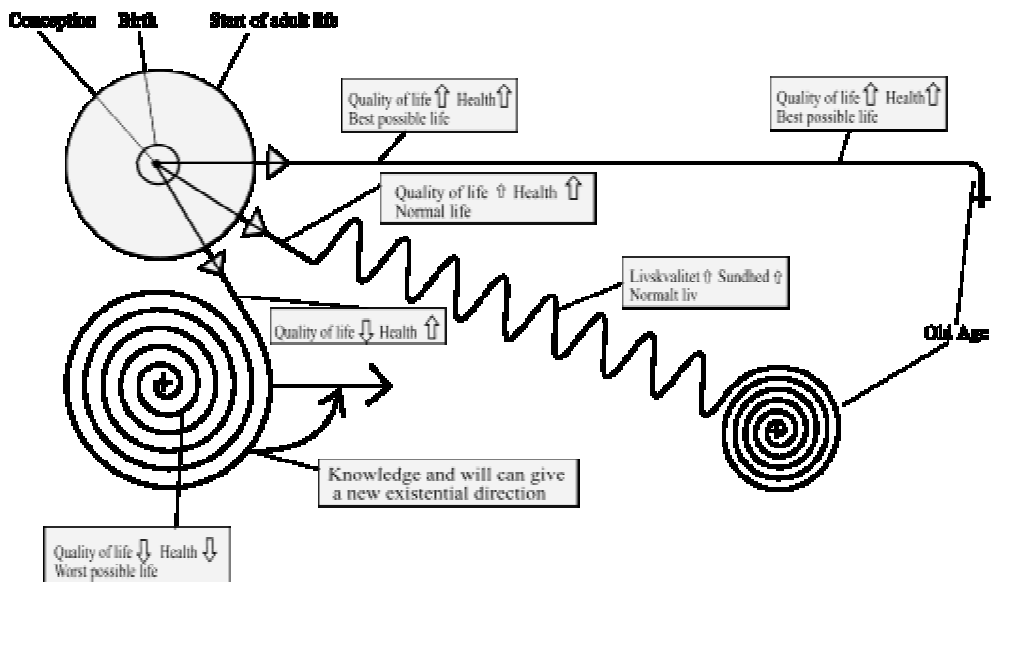
FIGURE 2 . The three paths of life[4]: the good life with optimal QOL, health and ability of functioning, the average, normal, life with sub-optimal QOL, health and ability, and the poor life with low QOL, ill health and bad functioning, lived by a quartile of the Danish